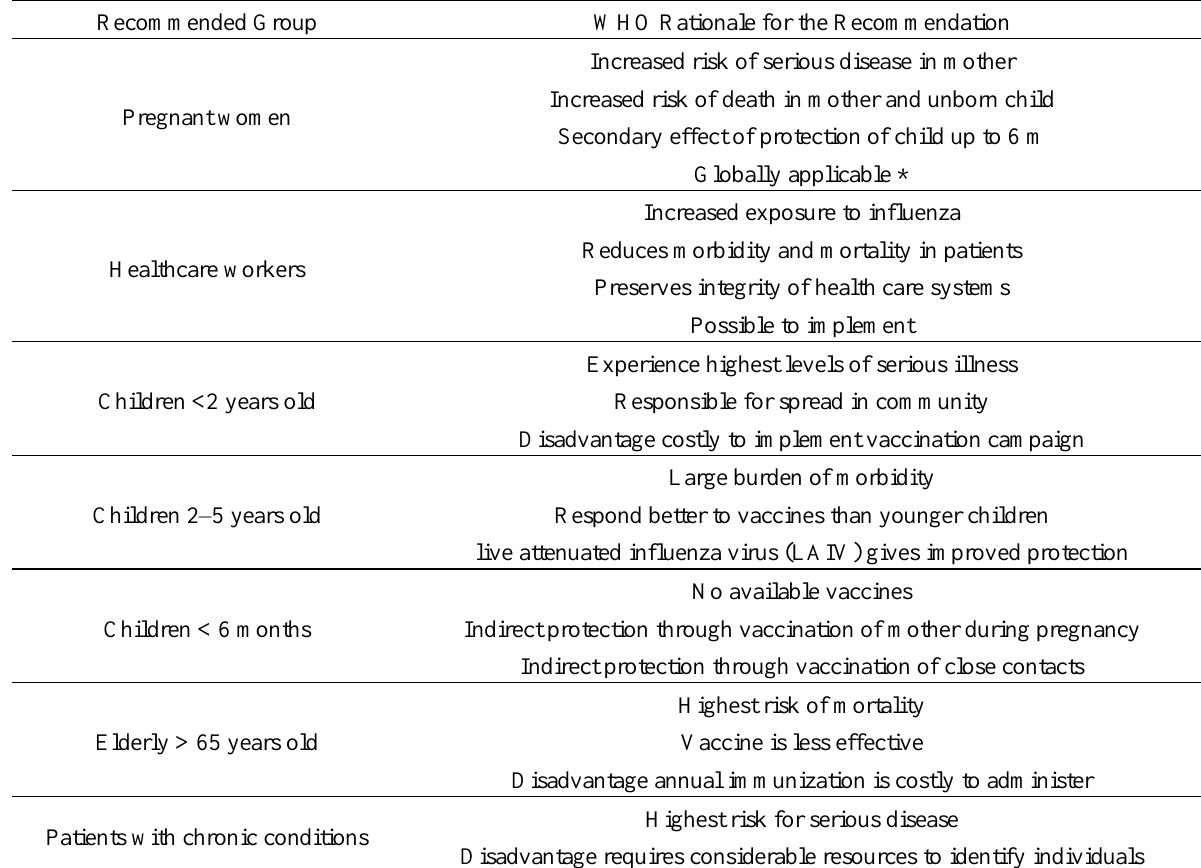
Table 1. The World Health Organization Strategic advisory committee influenza vaccine recommendations in prioritized